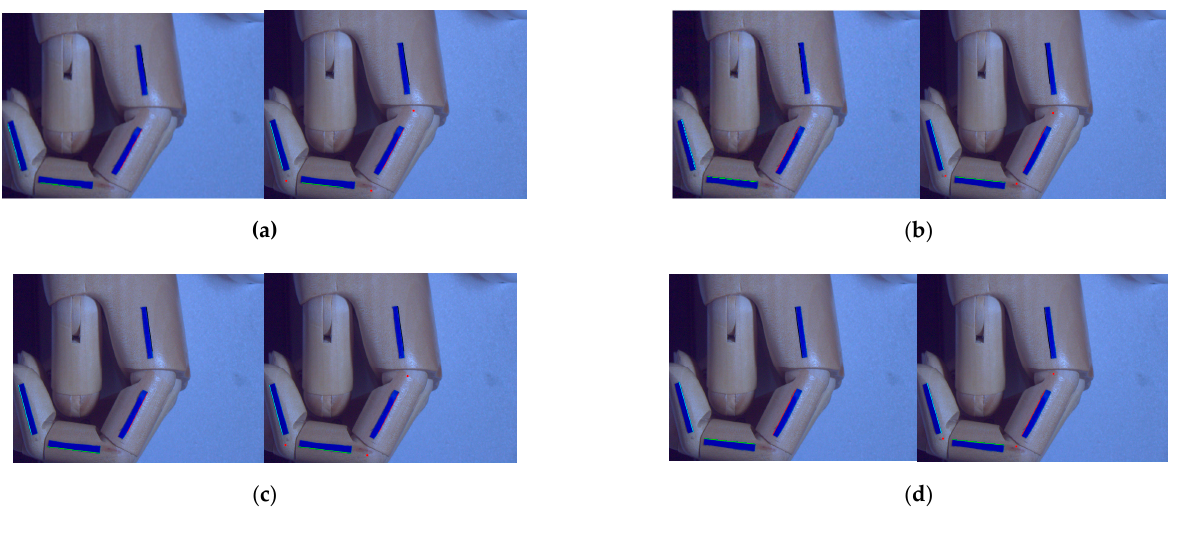
Figure 9. Inner and outer Hough straight-line detection results.